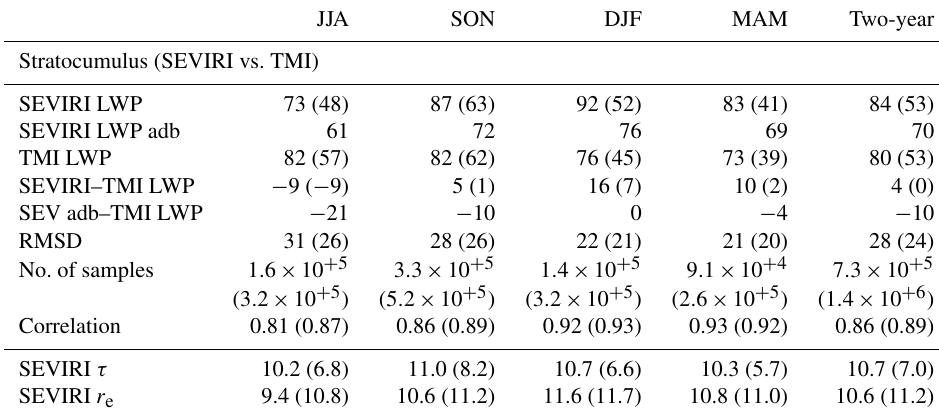
Table 1. The 2-year-mean and seasonal statistics of collocated SEVIRI and TMI LWP retrievals for rain-free, ice-free, smoke-free (AI < 0 . 1), τ > 3, and overcast (LCF ≥ 95%) grid cells over the marine stratocumulus region. LWP means, biases (SEVIRI–TMI), and root mean square deviations (RMSDs) are given in gm − 2 . The τ means and r e means (in µm) are also tabulated. The values in brackets are statistics without filtering for LCF ≥ 95% and τ > 3, i.e., for the all-sky case. The “adb” label refers to the overcast LWP calculation assuming adiabatic clouds. JJA SON DJF MAM Two-year Stratocumulus (SEVIRI vs. TMI) SEVIRI